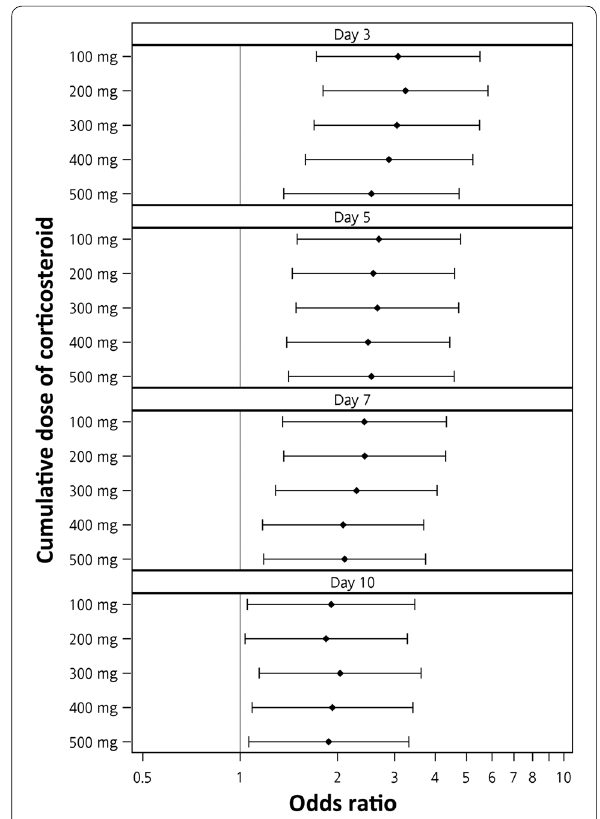
Fig. 1 Sensitivity analysis. Using univariate logistic regression analyses, the effects of corticosteroid treatment (defined